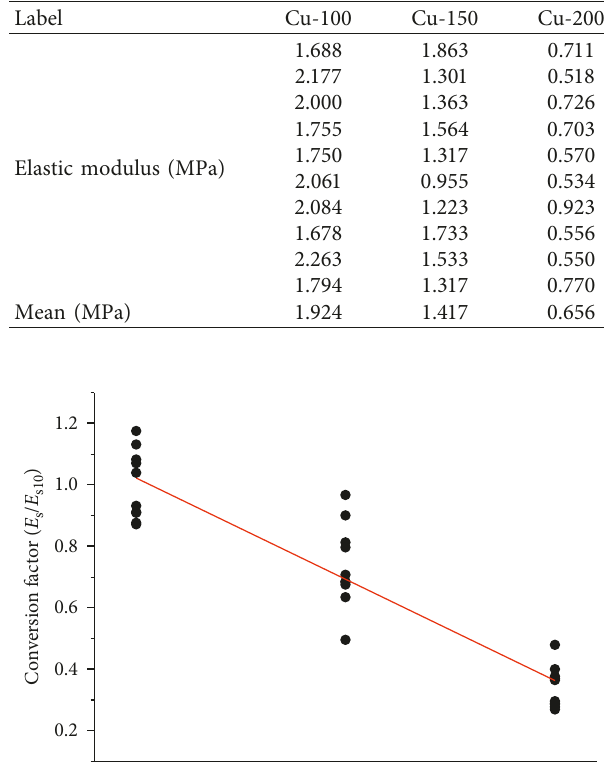
Table 3: The elastic modulus of CEB.